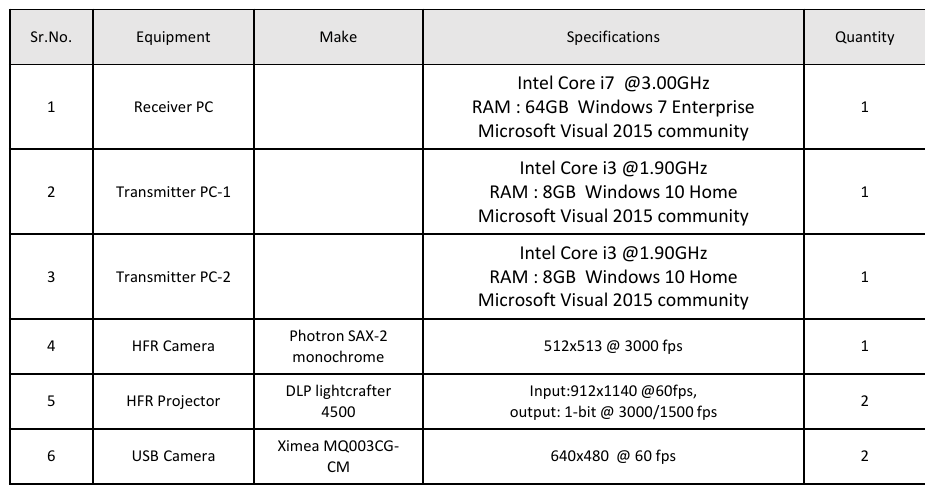
Figure 17. Experimental hardware with their specifications.